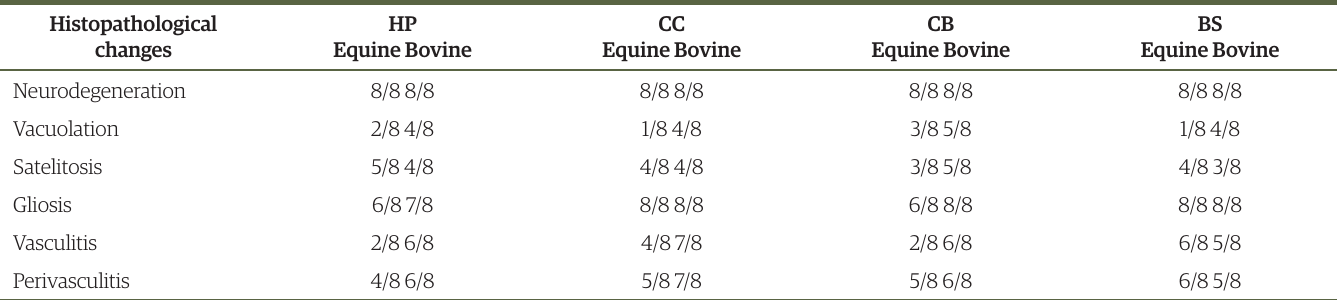
Histopathological